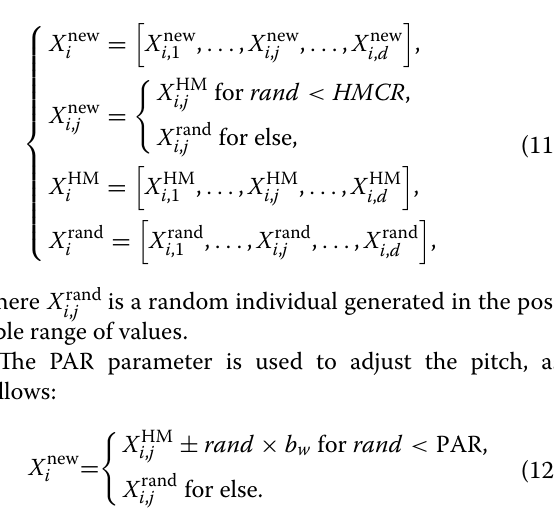
Figure 4 Second penalty factor of the optimized VMD